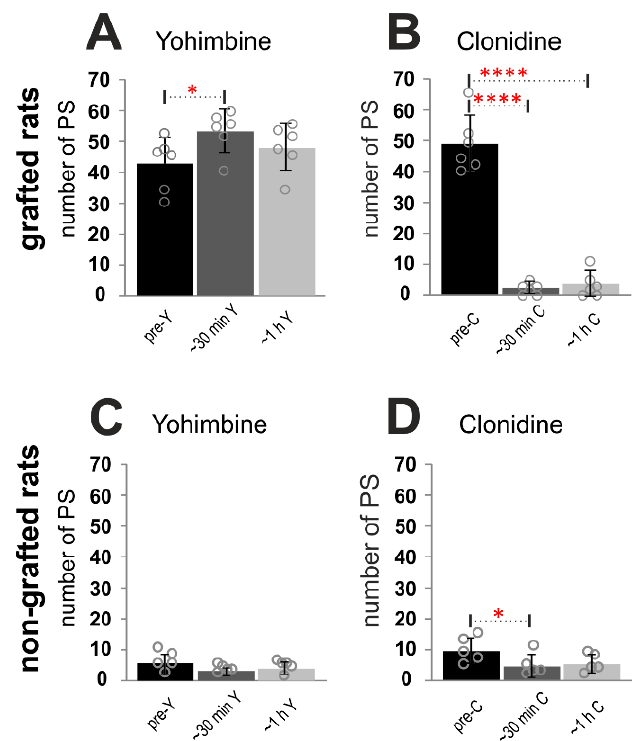
Figure 6. Number of proper plantar steps (PS) in 40 s test of the locomotor performance induced by tail pinching of spinal grafted ( n = 6) rats ( A , B ) and spinal non-grafted ( n = 5) rats ( C , D ) on the treadmill (10 cm / s) before and after application of yohimbine ( A , C ) or clonidine ( B , D ). The bars represent means ± SD established for the two groups animals (with and without a graft) in various experimental conditions, while gray circles present the data from individual rats. RM ANOVA with Tukey’s multiple comparisons test : * p < 0.05; **** p < 0.0001. ~30 min: < 30 min after drug application;